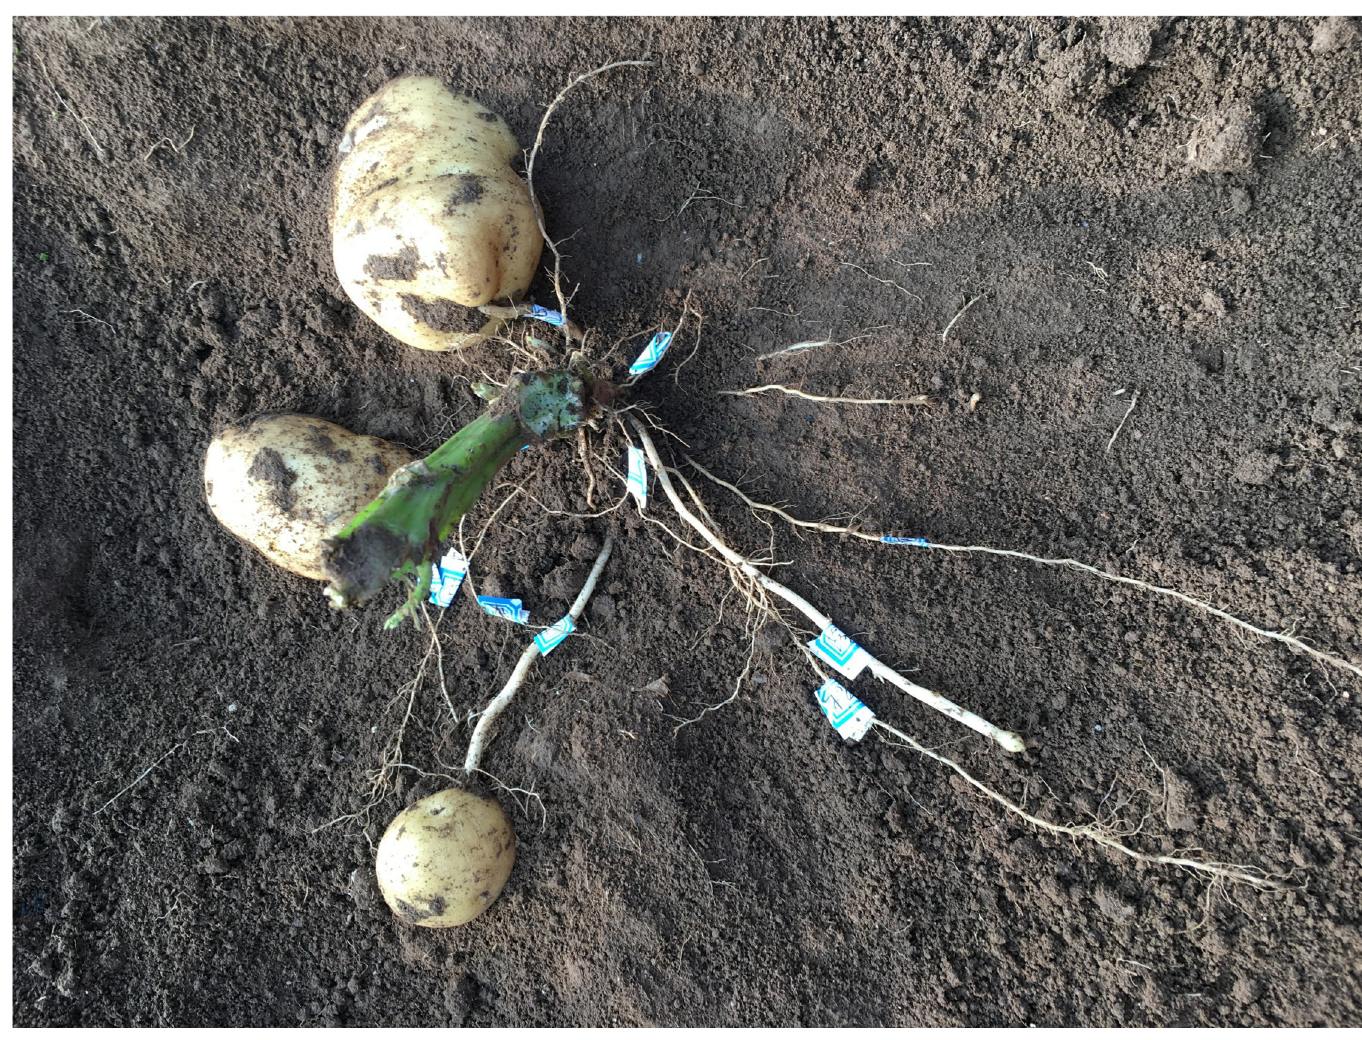
Fig 5. Open root